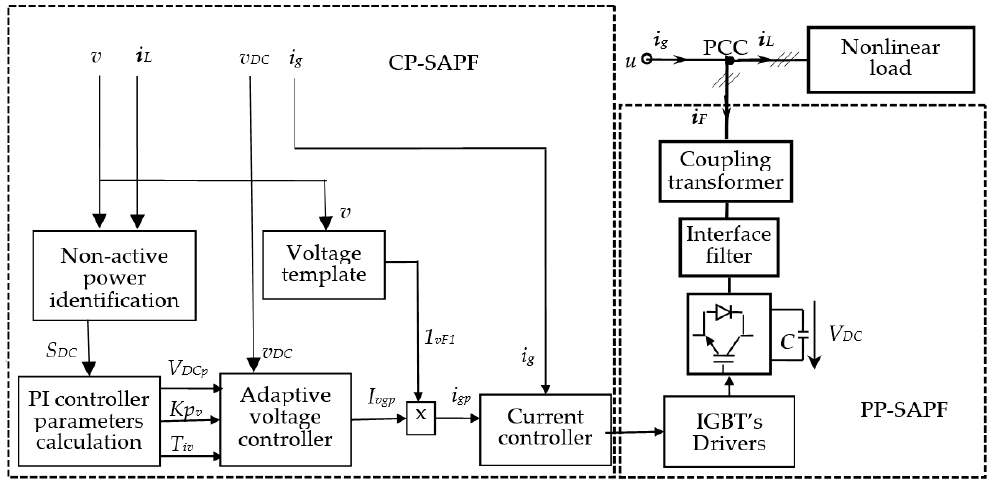
Figure 3. The system of the shunt active power filter (SAPF) with indirect current control.